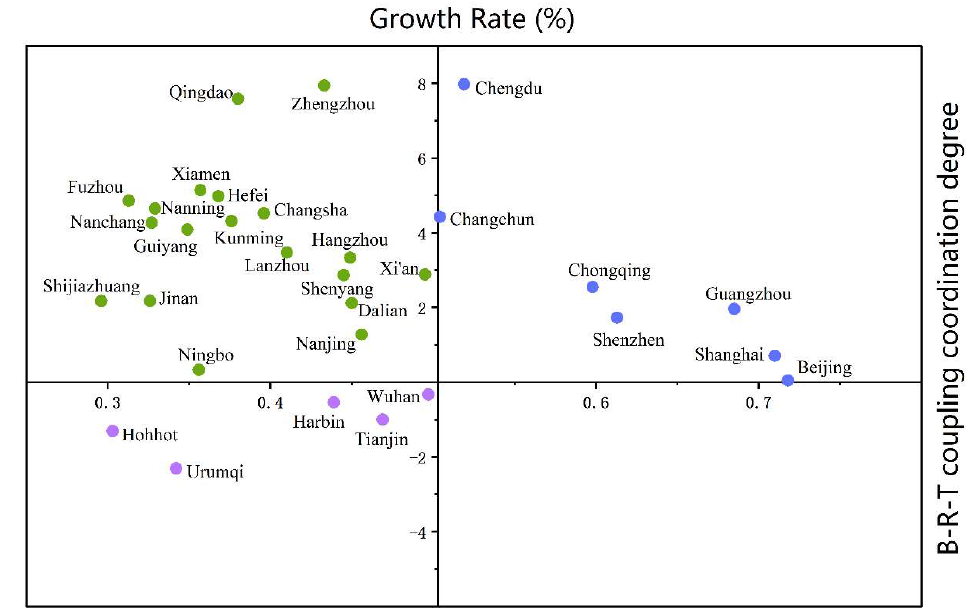
Figure 5. Coupling coordination relationship among B-R-T in 31 cities in China. Beijing, Shanghai, Guangzhou, Shenzhen, Chongqing, Chengdu, and Changchun